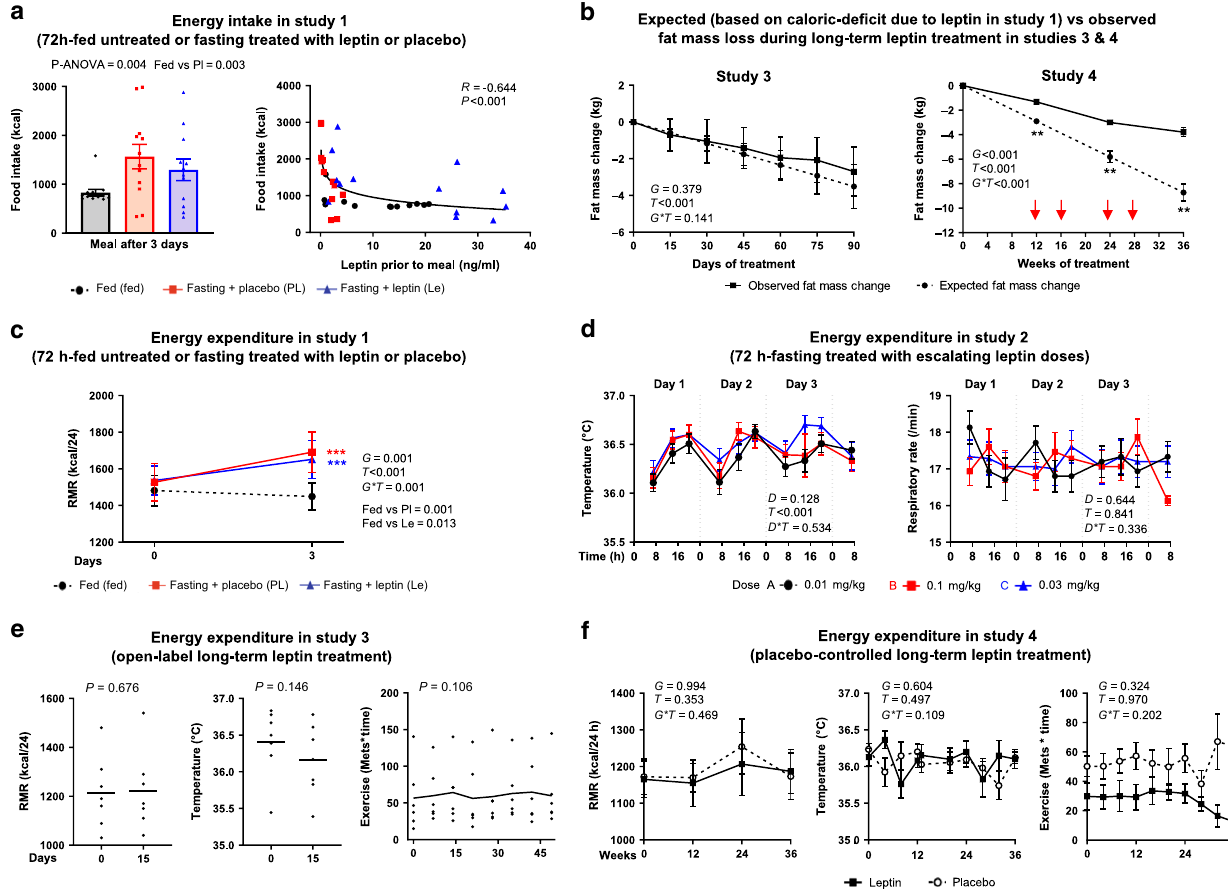
Fig. 3 Short- and long-term leptin effects on energy intake and expenditure. a Energy intake after 72-h in fed state, fasting + placebo, or fasting + leptin (study 1, n = 13). P values from repeated measure ANOVA and post hoc Bonferroni test are reported. R, correlation coef fi cient. b Expected (based on leptin-induced caloric de fi cit in study 1) vs observed fat mass loss during long-term leptin treatment in studies 3 and 4. As per the protocol, in study 4, if a subject lost >5% of baseline weight, the dose was reduced by 0.04 mg/kg (red arrows). P values of G (group: observed or expected fat mass change), T (days/weeks of treatment), and G * T interaction of mixed models are reported. By G * T < 0.05, post hoc Bonferroni test was performed: two asterisks indicate P < 0.01 for observed vs expected fat mass change at the speci fi c timepoint. c Energy expenditure during 72-h fed state, fasting + placebo, and fasting + leptin (study 1, n = 13). P values of G (group: fed, fasting + placebo, fasting + leptin), T (days of treatment), and G * T interaction of mixed models adjusted for baseline are reported. Post hoc Bonferroni test was performed between the estimated means of the three groups and between the three groups at each timepoint. Three asterisks indicate P < 0.001 for fed vs fasting + placebo (red) and fed vs fasting + leptin (blue). d Energy expenditure during 72-h fasting treated with escalating leptin doses (study 2, n = 15). P values of D (dose: 0.01, 0.1, and 0.3 mg/kg/d), T (hours of fasting), and D * T interaction of mixed models adjusted for baseline are reported. e Energy expenditure during open-label long-term leptin treatment in mildly hypoleptinemic women (study 3, n = 7). P values of paired t test (RMR and body temperature) and of time effect of mixed models adjusted for baseline (exercise score) are reported. No post hoc test was performed since P > 0.05. f Energy expenditure during placebo-controlled long-term leptin treatment in mildly hypoleptinemic women (study 4, n = 19 (leptin = 10; placebo = 9)). P values of G (group: placebo or leptin), T (weeks of study), and G * T interaction of mixed models adjusted for baseline are reported. No post hoc test was performed since G * T > 0.05. All P values are two-sided. For post hoc Bonferroni test, only signi fi cant results are reported. Data are demonstrated as means ± SEMs. Exact P values: a Correlation of food intake with leptin prior to meal